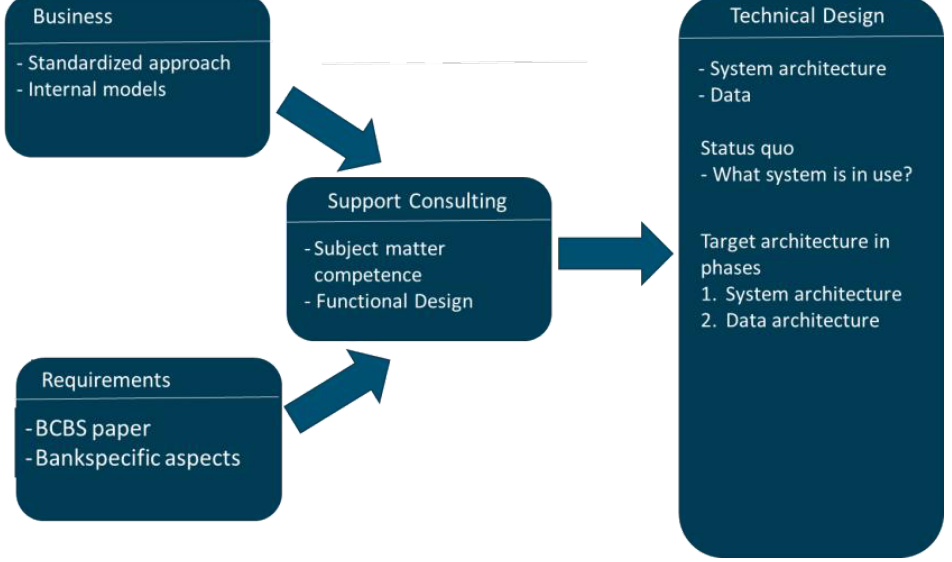
Figure 4. Influence factors of technical design.